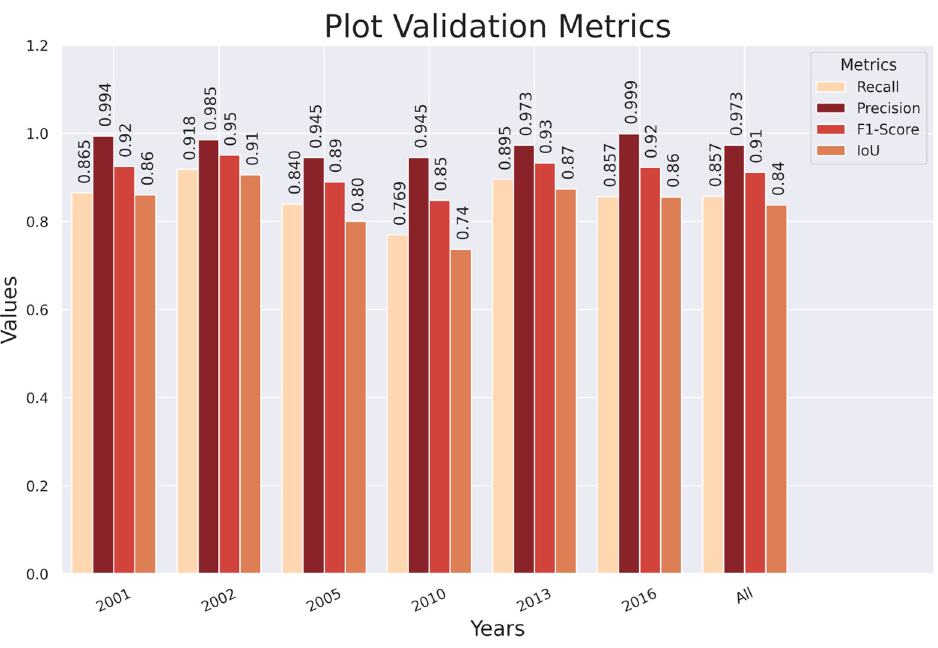
Figure 14. Result validation metrics: recall, precision, F1-score and IoU.